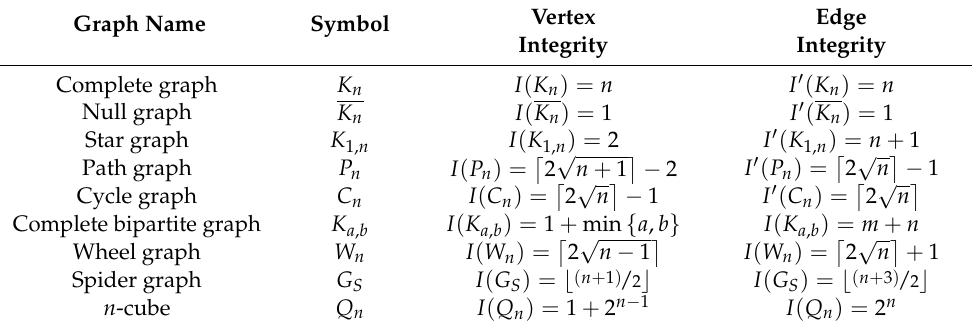
Table 1. Integrity of some well-known kinds of